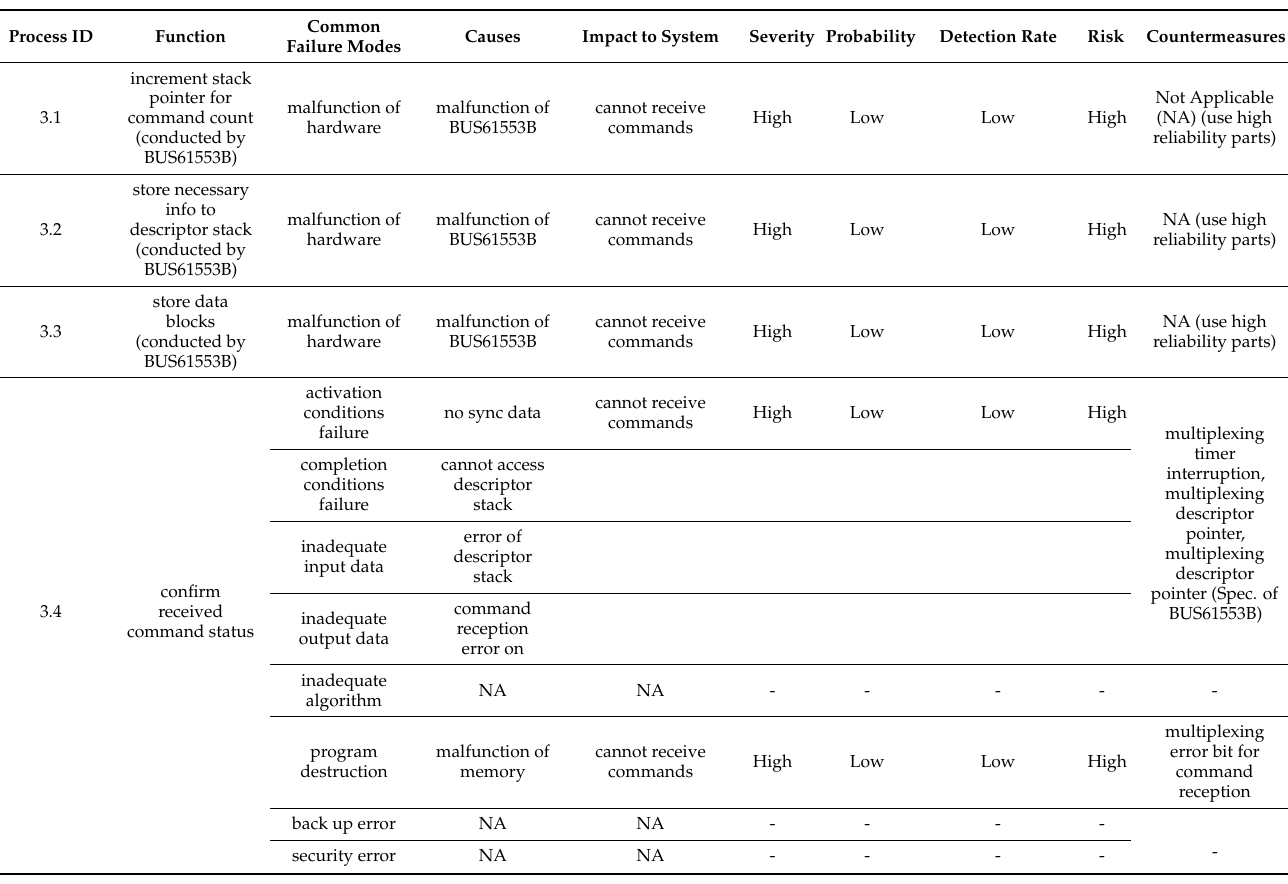
Table 3. Result of